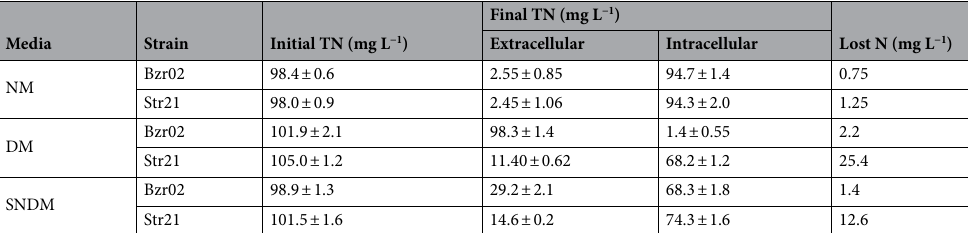
(Table 3). Only a small fraction of nitrogen was lost for Bzr02 and Str21 (0.75 and 1.25 mg L −1 , respectively;